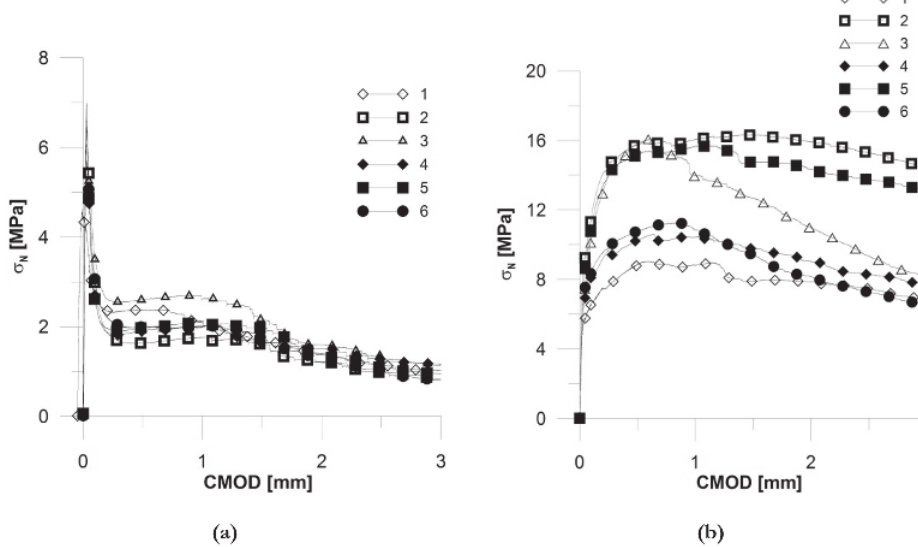
Resultados dos ensaios à flexão em três pontos de acordo com o EN 14651